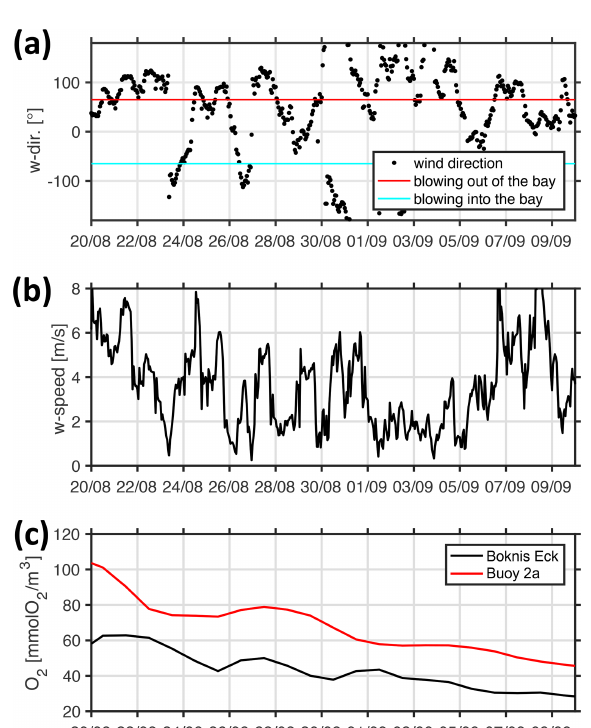
Figure 15. Simulated temporal evolution of (a) wind direction, (b) wind speed, and (c) bottom oxygen concentrations during the buildup of the 2017 hypoxic event. The black and red lines in panel (c) refer to station Boknis Eck at the entrance and station Buoy 2a deep inside EB,